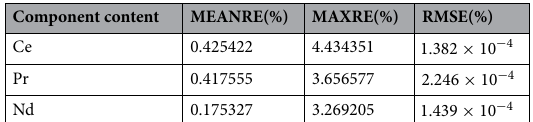
Table 1. Relative error of each component after